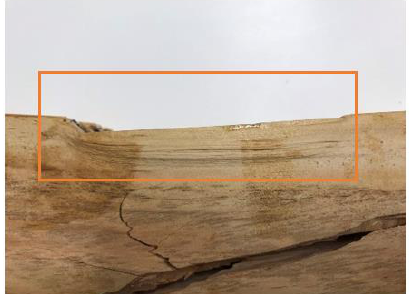
Figure 4. A slow deformation is seen at the compression (top) zone of the 40 × 80 beam sample.